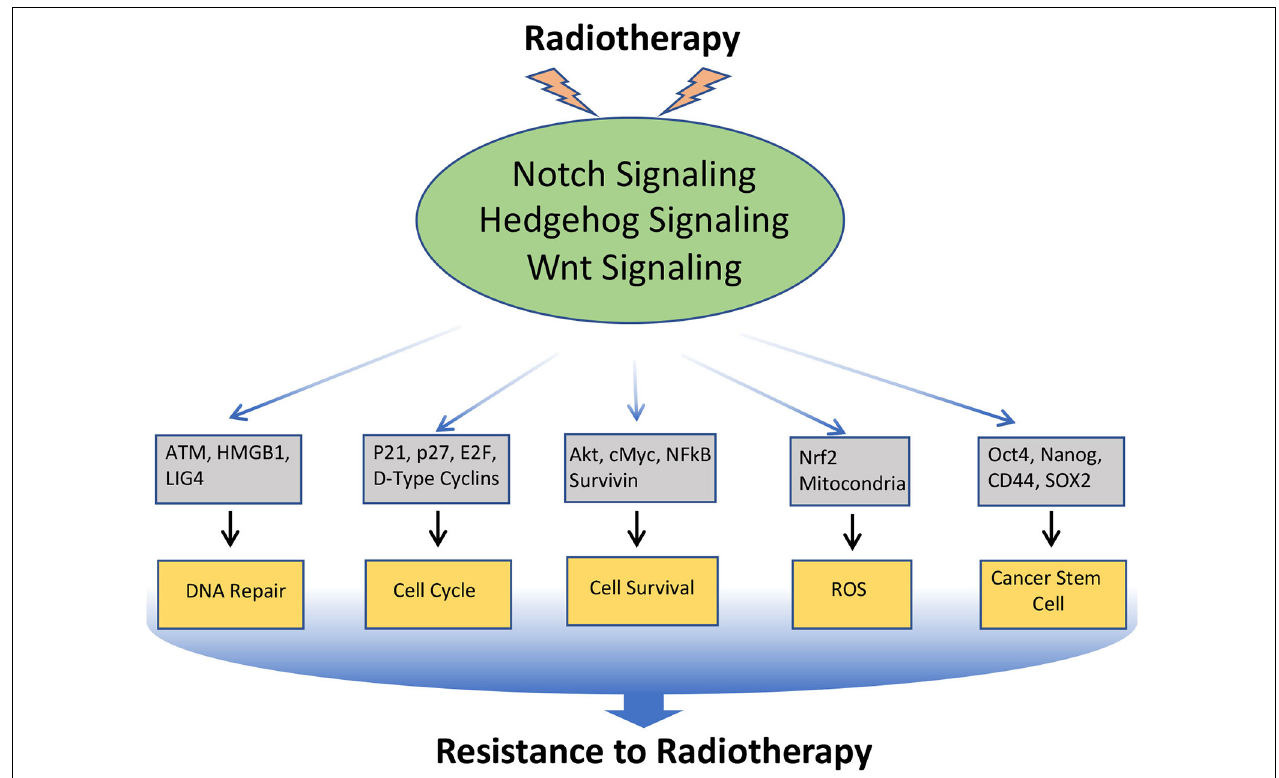
FIGURE 4 | Involvement of Notch, Hedgehog, and Wnt signaling pathways in the resistance of cancer cells to Radiotherapy: Radiotherapy often induces Notch, Hedgehog, and Wnt signaling in cancer, which in turn regulates the key molecules involved in DNA repair, cell-cycle, cell survival, ROS generation, EMT, and CSC, that leads to the acquisition of radioresistance in